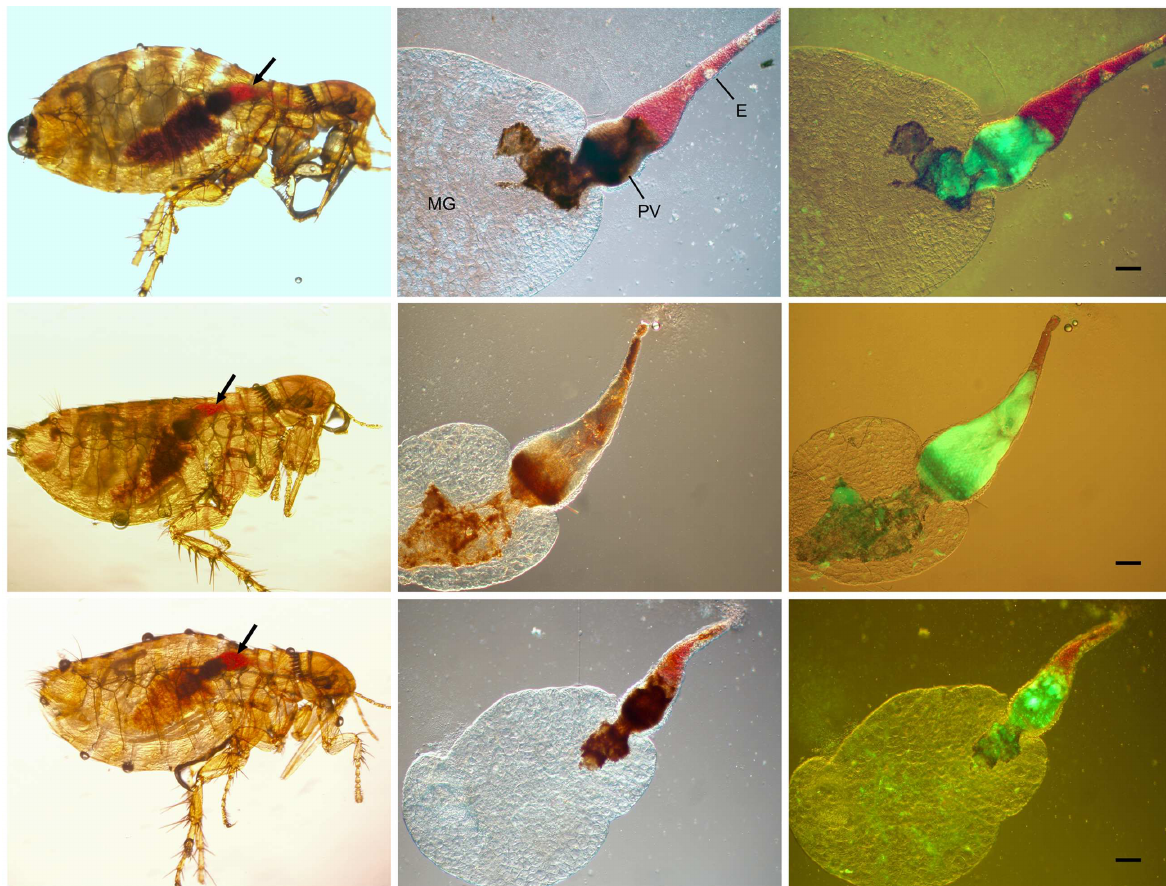
Fig 2. Y . pestis causescomplete proventricular blockage in O . montana fleas. The left panels show the typical blockagephenotype in O . montana fleas immediately after a feedingattempt. Fresh red blood (arrows) that was unableto enter the midgut (MG) is seen in the esophagus (E). The fleas were infected with GFP-expressing Y . pestis . The middle and right panelsare images of the dissected digestivetracts from the same fleas visualizedby DIC and a combination of DIC + fluorescence microscopy, respectively,and confirm the presenceof a dense Y . pestis biofilm that completelyfills and blocks the proventriculus (PV). Scale bars = 100 μ m.